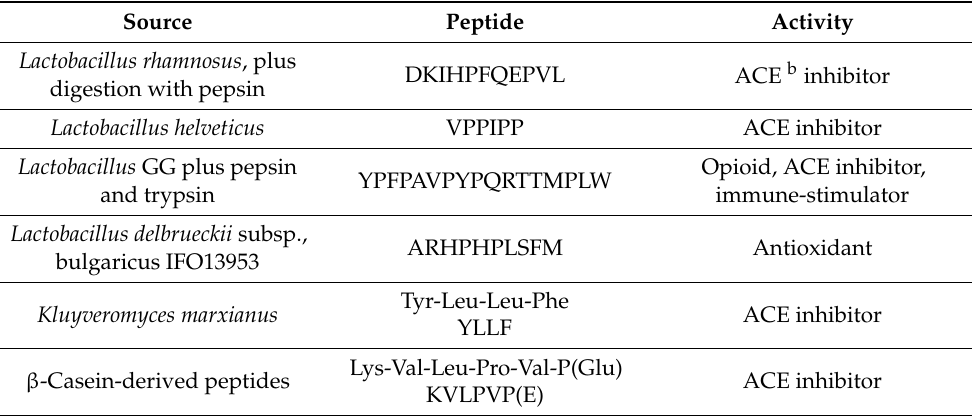
Table 1. Relevant bioactive peptides obtained from bovine milk caseins by the action of microbial proteases a .